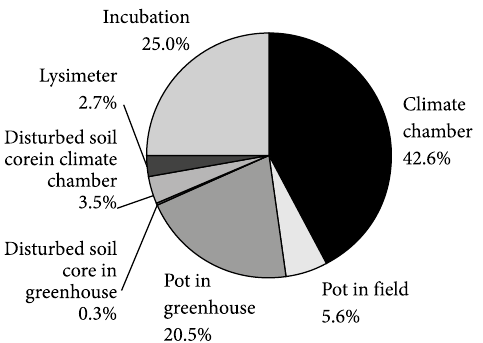
Fig. 1. Survey response of types of experiment (n = 356)